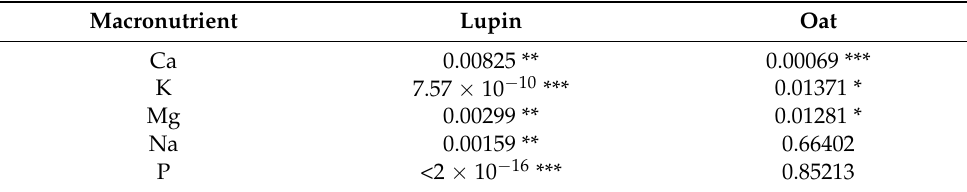
Figure 1. The effect of treating the soil with two amendments on mean Ca, K, Mg, Na and P amounts in lupine grown on soils: T0—control soil, TI—soil with compost addition and TII—soil with FA addition. In the figure, the letters denote homogenous groups. Table 2. p -values from one-way ANOVA determined separately for each macronutrient in lupine and oat. Comparison between T0—control soil, TI—soil with compost addition and TII—soil with FA